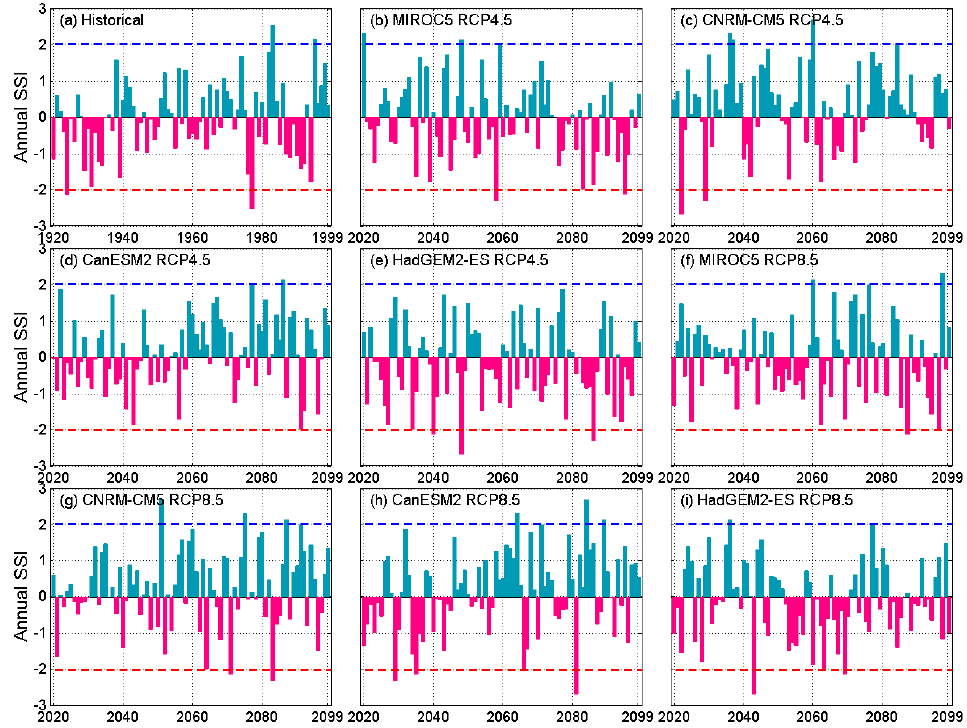
Figure A4. Historical and projected annual SSI for SAC4. Values above the blue dash line represent extremely wet condi ‐ tions while values below the red dash line indicate extremely dry conditions.